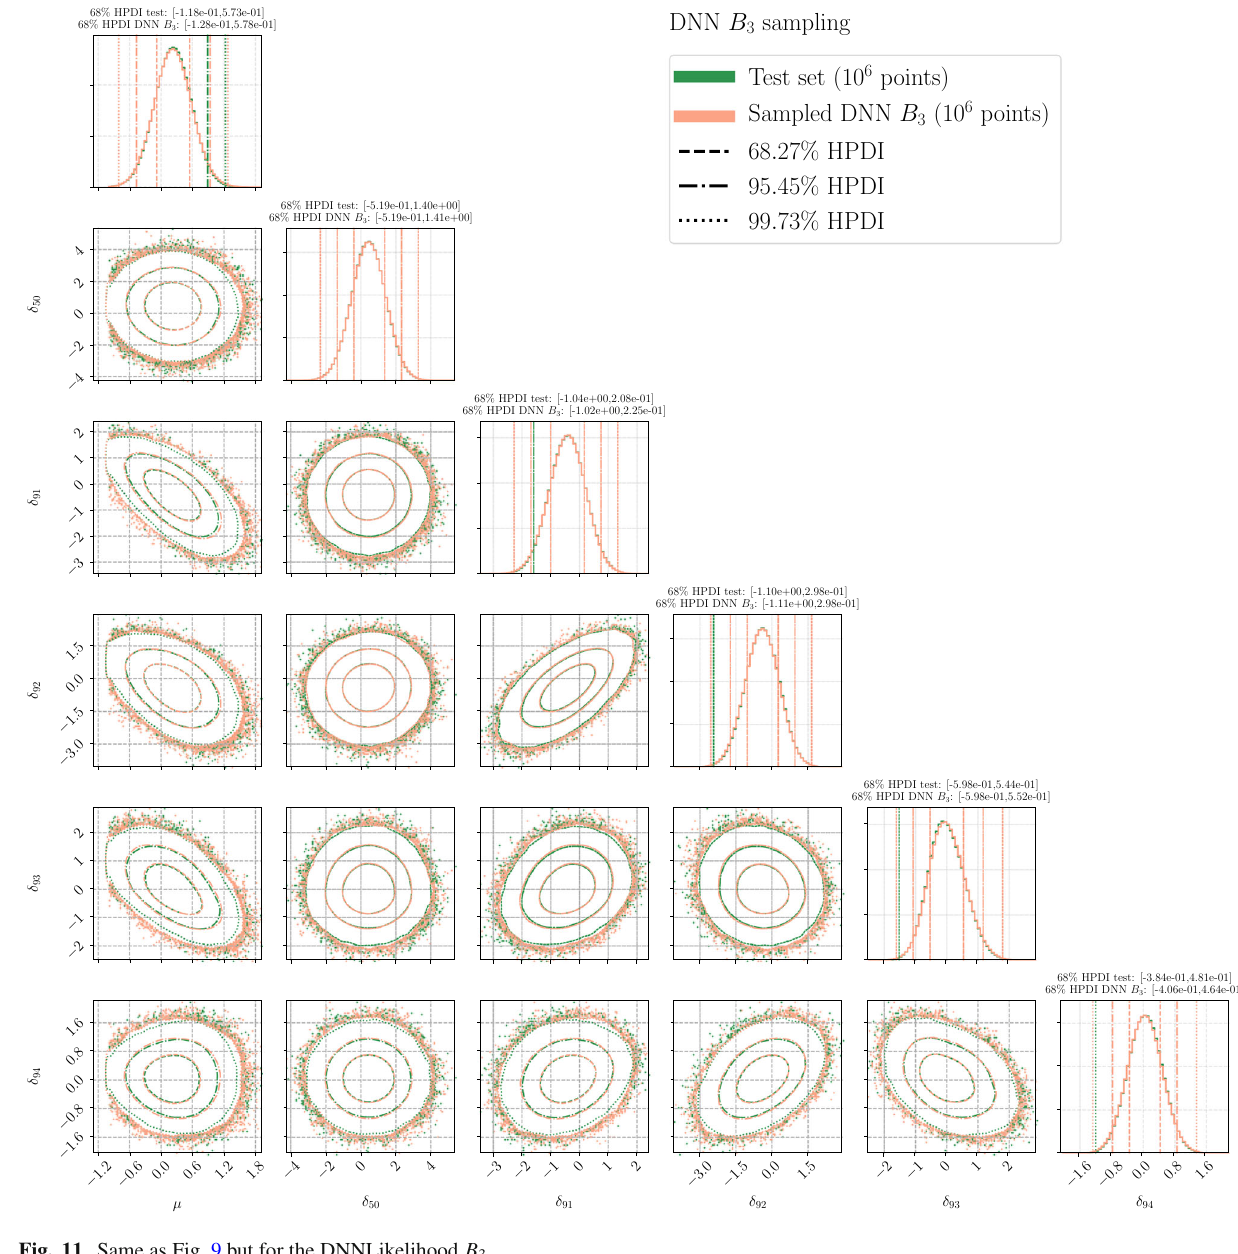
μ in the hypothesis μ > 0 and should be compared with the last